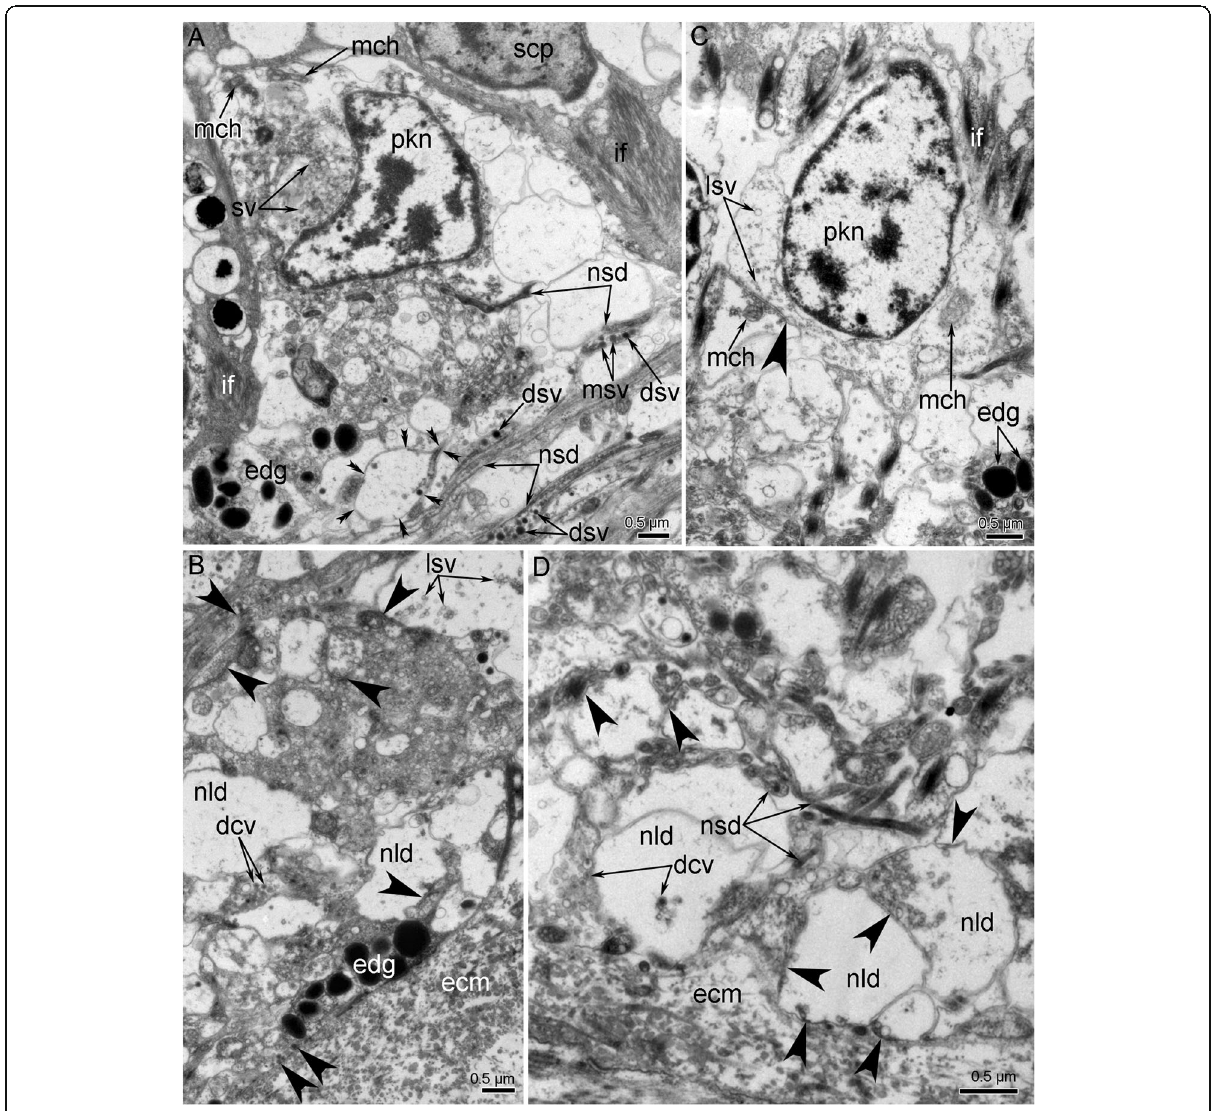
Fig. 12 Ultrastructural details of the outer ( A , B ) and circumoral nerve rings ( C , D ) of the anterior nerve center of Owenia borealis . A , C Perikarya, which are surrounded by supportive cells and their projections. B , D The basal portions of neuropil. Varicose of neurite of second type is shown by double arrowheads. Synaptic-like structures, which are characterized by cell membrane density and by synaptic vesicle concentration, are indicated by arrowheads. Abbreviations: dcv – dense-core synaptic vesicle; dsv – dense synaptic vesicles; ecm – extracellular matrix; edg – electron dense granules; if – intermediate filaments; lsv – light synaptic vesicle; mch – mitochondrion; msv – synaptic vesicle with content of middle electron density; nld – neurite of large diameter; nsd – neurite of small diameter; pkn – nucleus of perikaryon; scp – supportive cell; sv